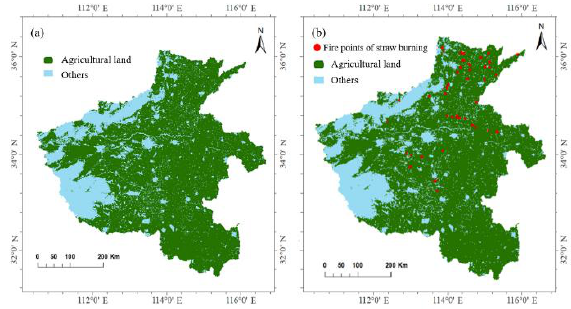
Figure 3 . Recognition results of straw burning points: (a) agricultural land in 2014; (b) fire points of straw burning on June 11,